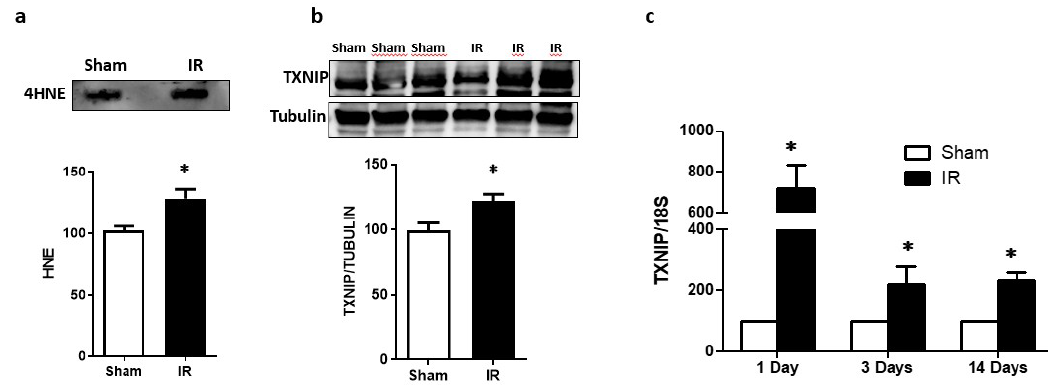
Figure 1. ( a ) Ischemia/reperfusion (IR) induced oxidative stress assessed by slot-blot analysis of 4- HNE level compared to sham-control after 1-day ( n = 3). ( b ) Representative western blot and statistical analysis showed significant increase in TXNIP expression 1day post-IR ( n = 3). ( c ) Statistical analysis of mRNA level assessed by realtime-PCR showed that IR induced the expression of TXNIP in WT mice after 1-day that was sustained for 3 and 14 days post-IR ( n = 4). * p < 0.05 vs sham.